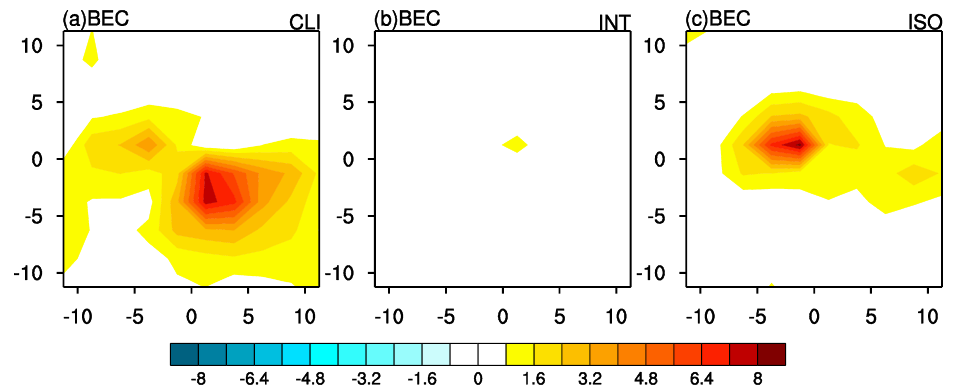
Figure 5. The same as Figure 4, except for composite barotropic energy conversion (10 − 5 m 2 /s 3 ) terms associated with ( a ) climatological mean winds (CLI), ( b ) interannual (INT), ( c ) intraseasonal back-